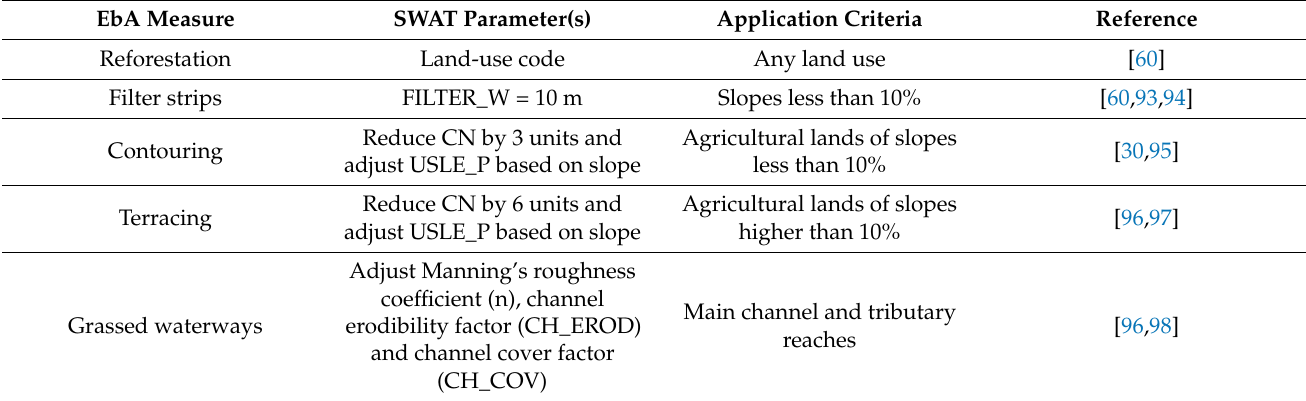
Table 5. Representation of EbAs in the SWAT